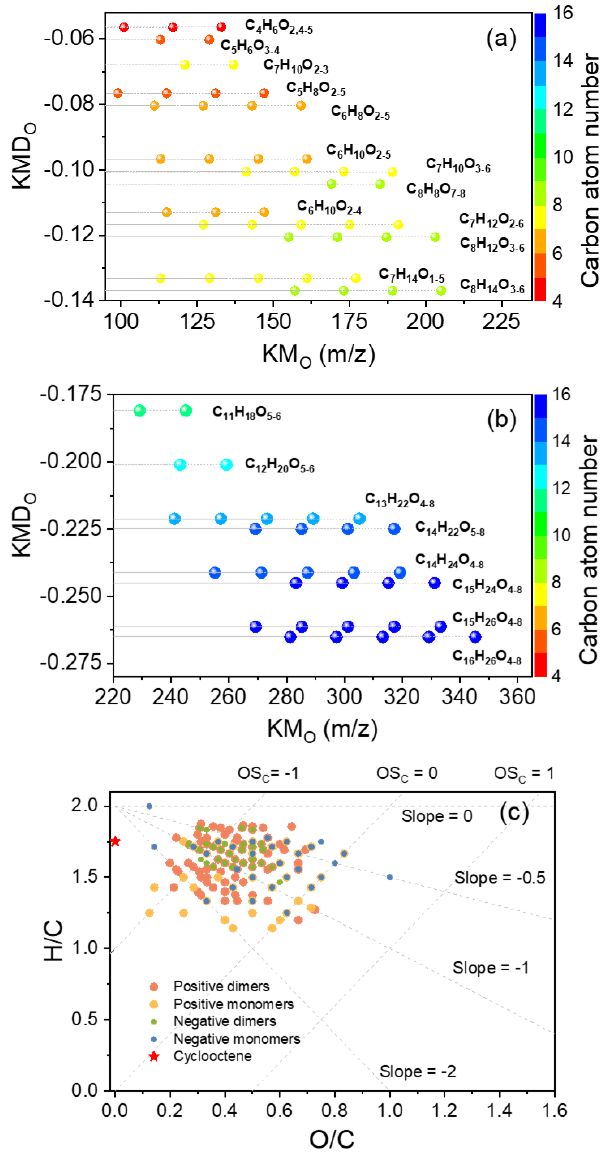
Figure 5. Oxidation products observed in particles produced from the ozonolysis of cyclooctene in the absence of SO 2 . Oxygen (O) Kendrick mass defect plots of (a) monomers and (b) dimers. (c) Van Krevelen